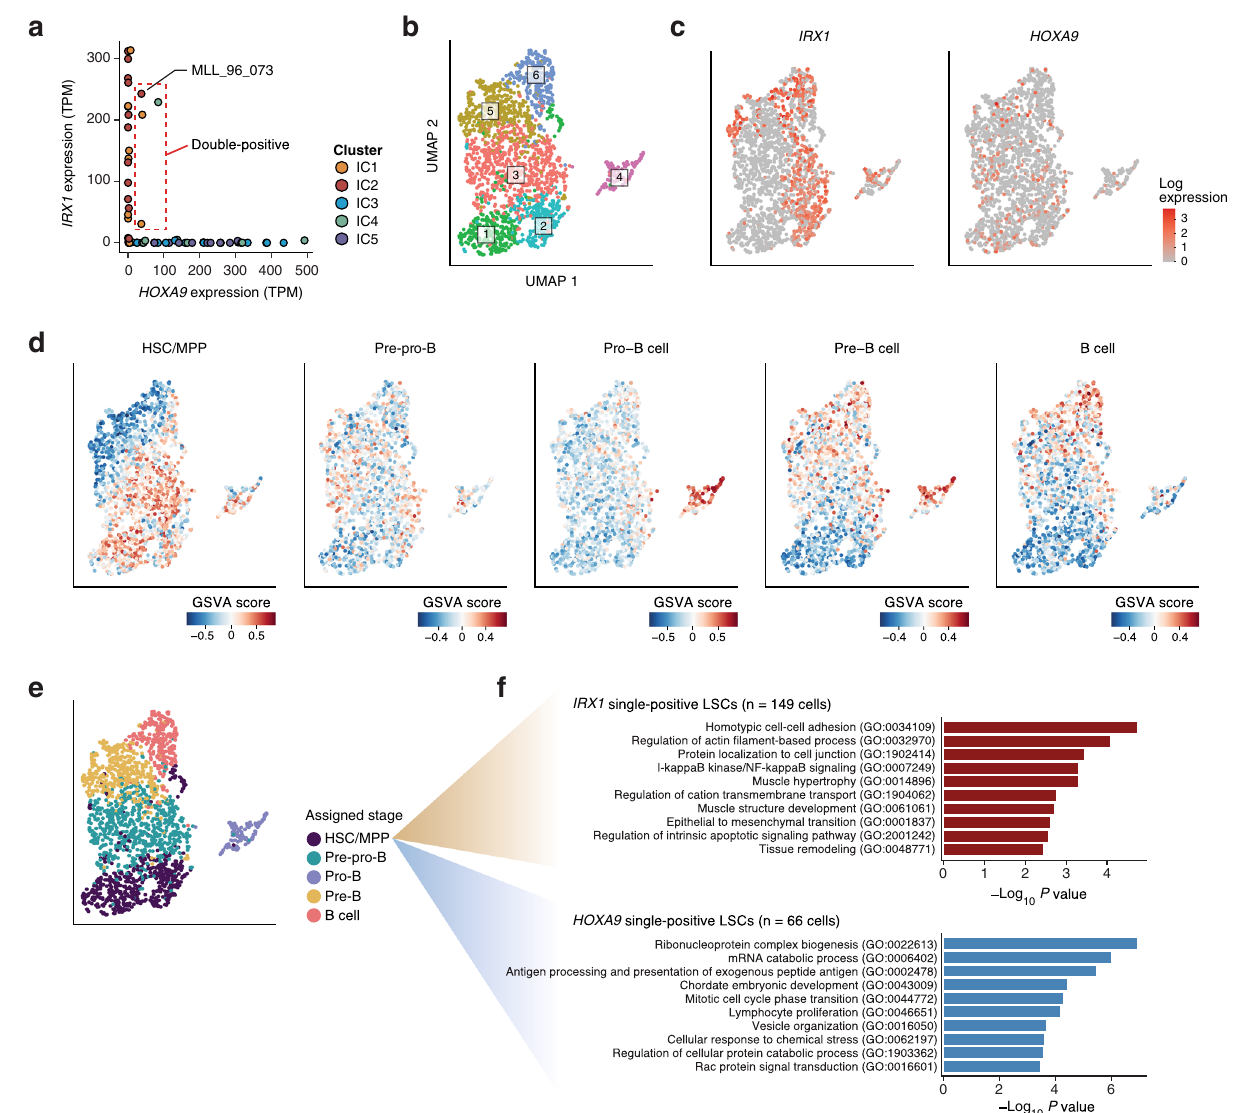
Fig. 5 | Single-cell transcriptome analysis of an infant with IRX/HOXA double- positive ALL. a Two-dimensional display of IRX1 and HOXA9 gene expression in each patient sample. A case of double-positive ALL (MLL_96_073) is denoted. b UMAPvisualizationofthesingle-celltranscriptomeofMLL_96_073.Clusterswere identi fi edwiththeLouvainmethod. c Lognormalizedexpressionvaluesof IRX1 and HOXA9 in the leukemia cells of MLL_96_073. d Single-cell-level enrichment of